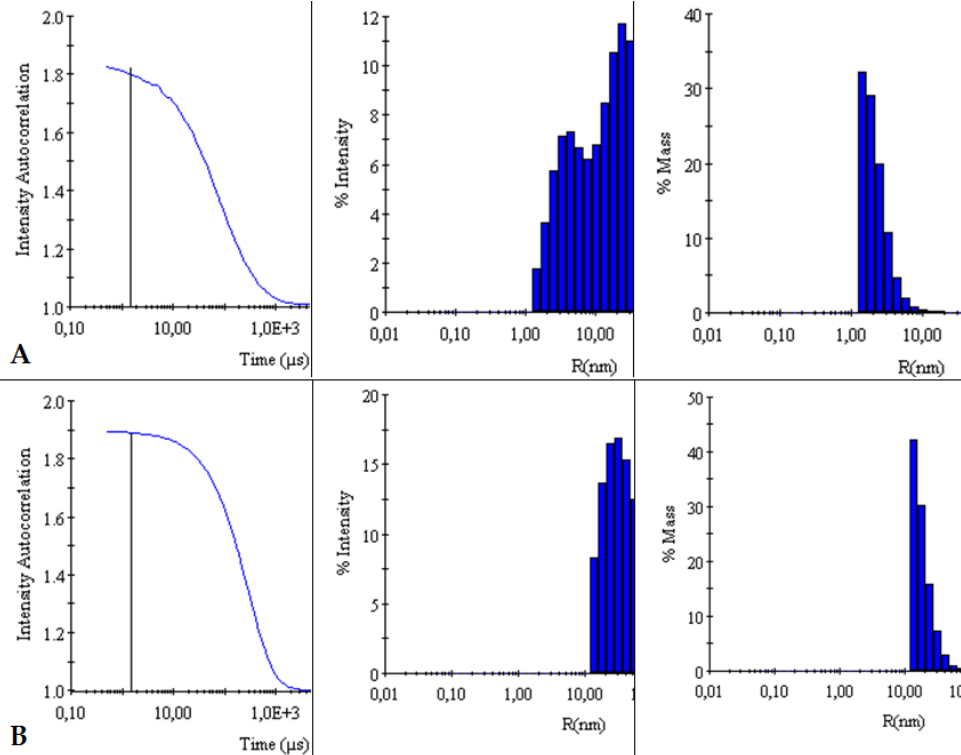
Figure 5. Comparison of intensity autocorrelation curves, % of intensity and % of the mass of: ( A ): TY and ( B ): TY-Ag.